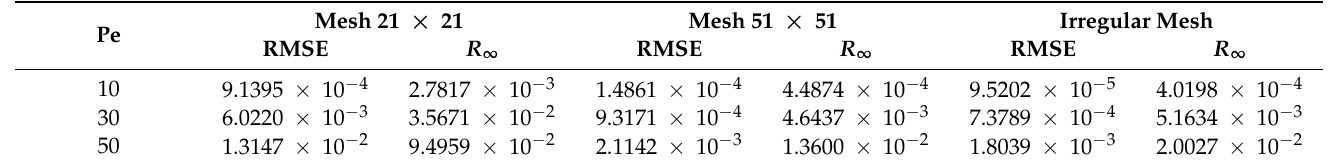
Table 1. Example No. 1—comparison of RMSE and R ∞ for different meshes and Pe values. Mesh 21 × 21 Mesh 51 × 51 Pe